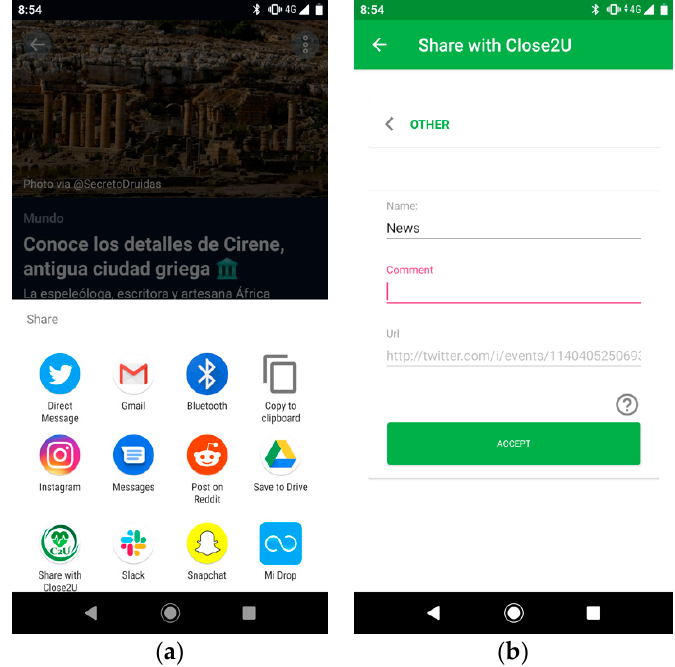
Figure 5. Screens of the user interface: ( a ) Share with Close2U in other application and ( b ) Share a resource with the URL taken from share option from other